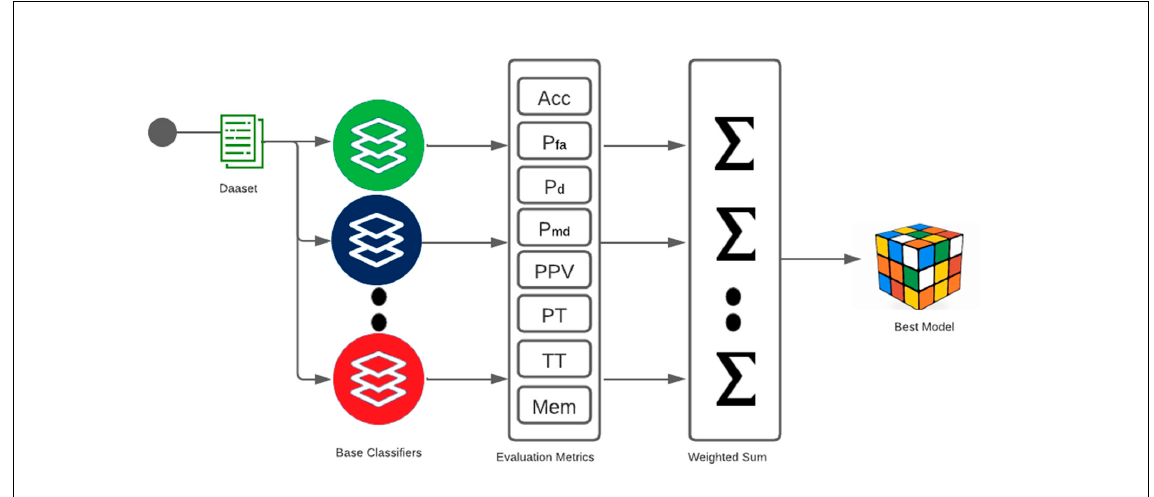
Figure 3. Workflow for the proposed approach, WSS.